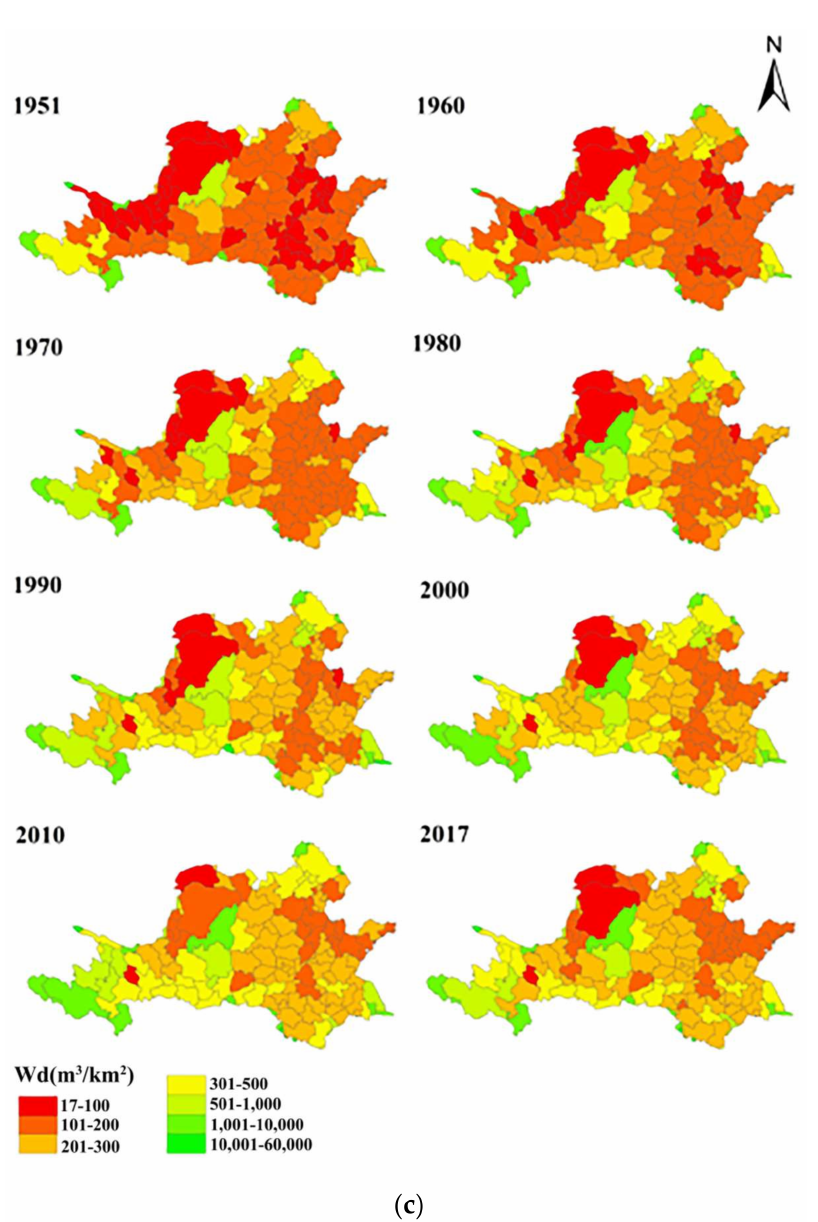
Figure 7. The spatial distributions of the WLN matching indexes for the different sectors for the cities in the Huang-Huai-Hai River Basin from 1951 to 2017 ( a ). The spatial distribution of the agricultural WLN matching index for cities in the Huang-Huai-Hai River Basin. ( b ). The spatial distribution of the industrial WLN matching index for cities in the Huang-Huai-Hai River Basin. ( c ). The spatial distribution of the domestic WLN matching index for cities in the Huang-Huai-Hai River